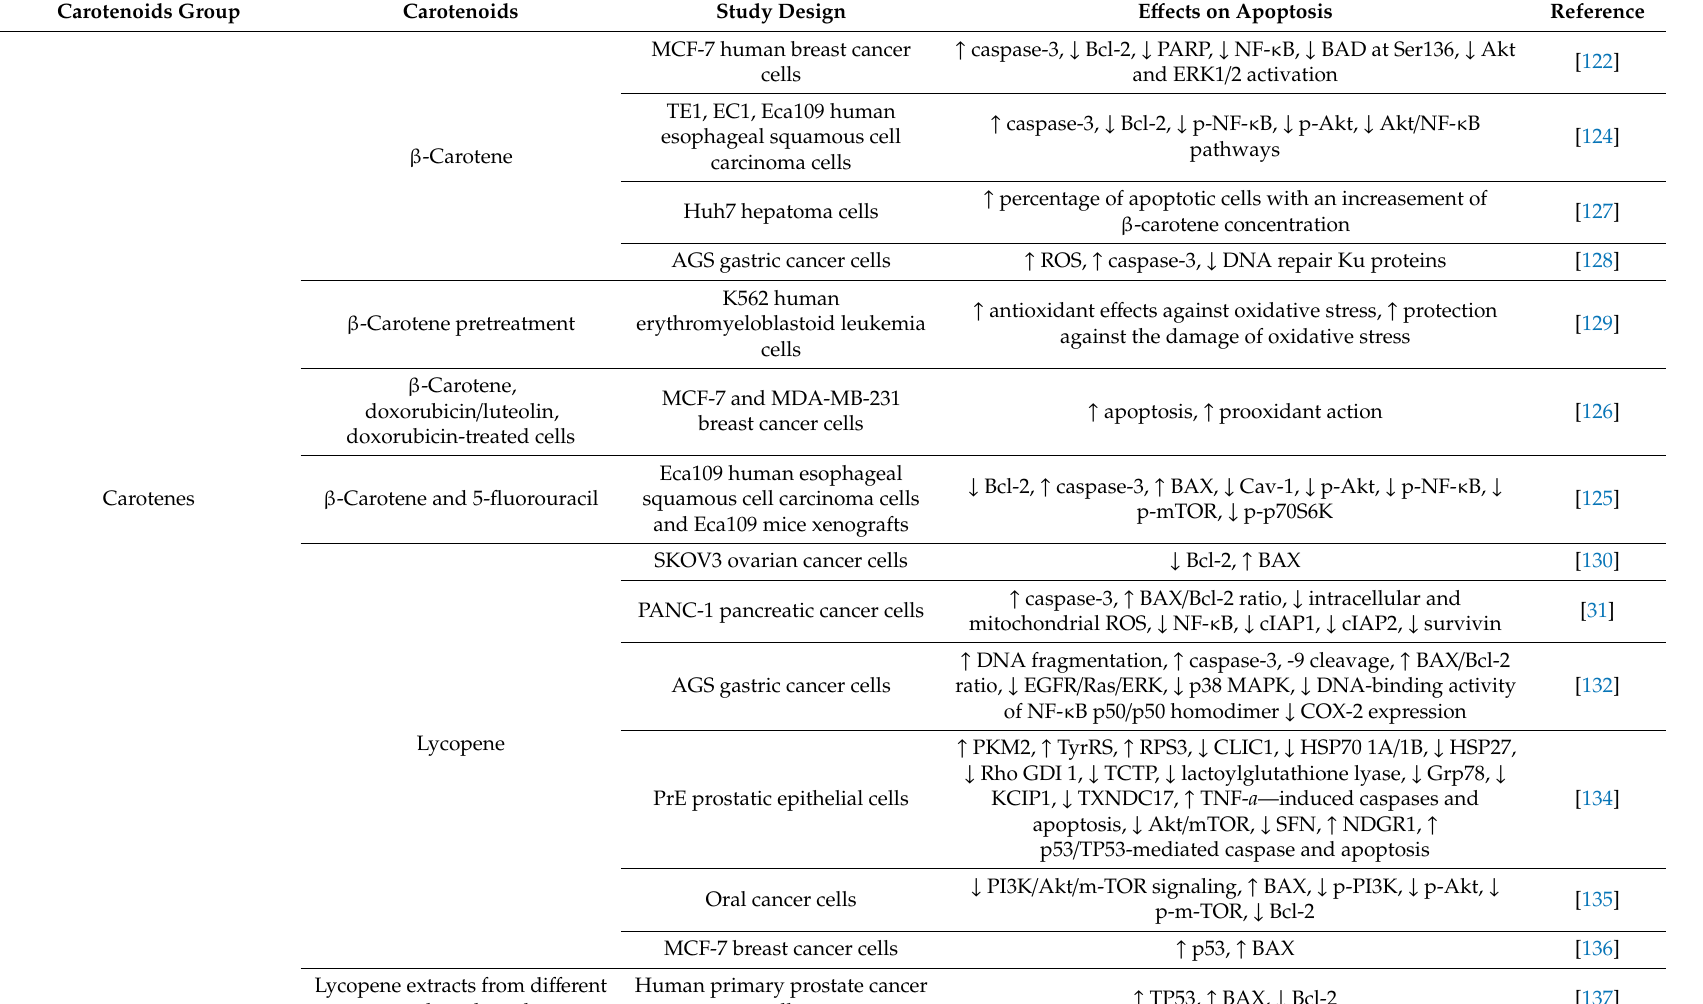
Table 2. The e ff ects of carotenoids on cancer